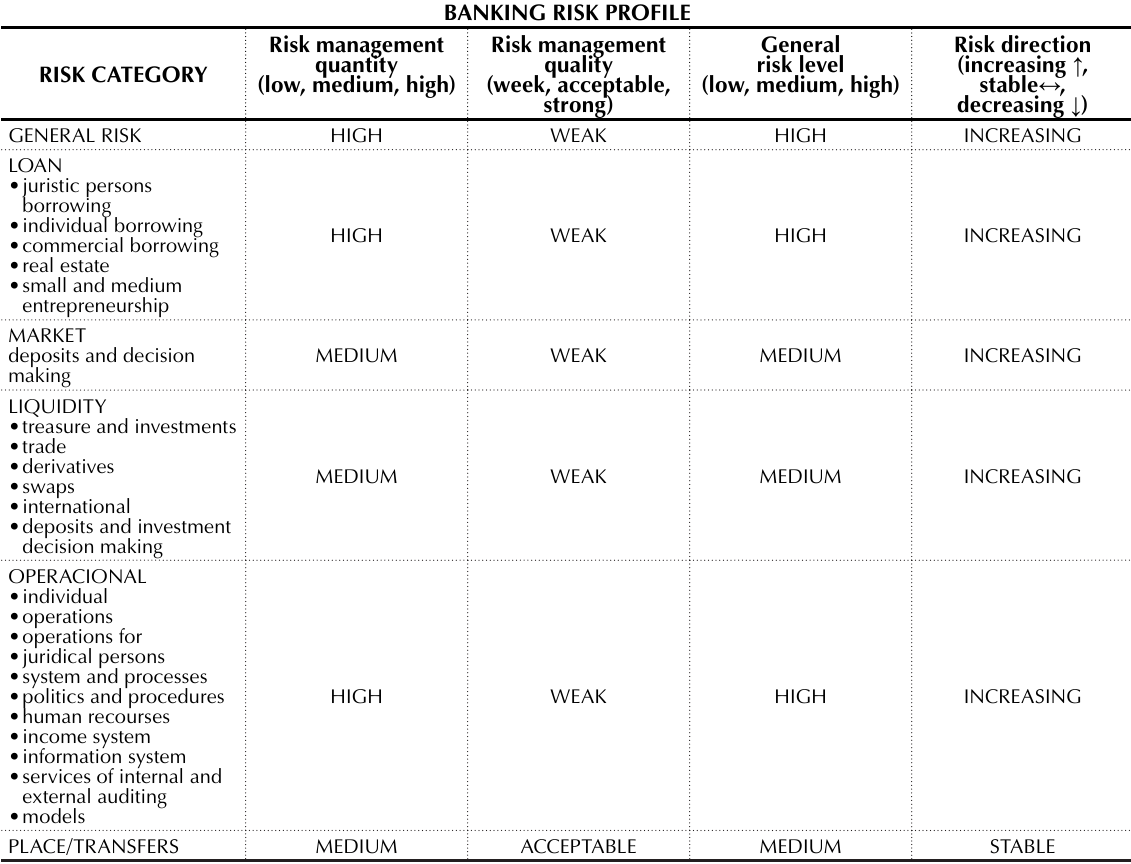
Table 1. Banking risk